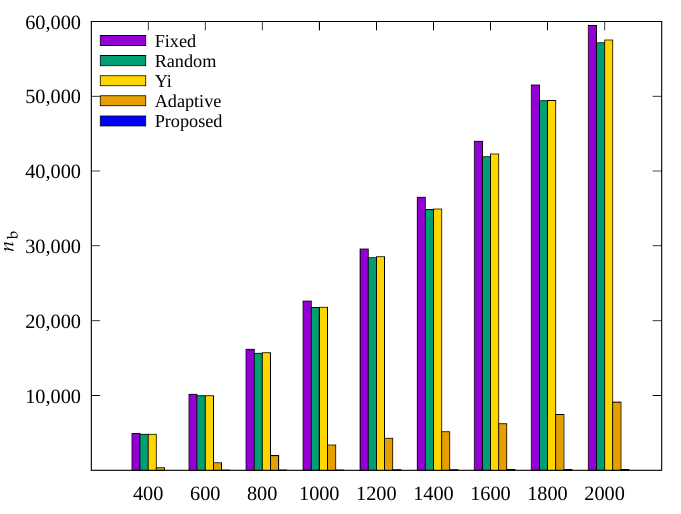
Figure 11. Change in total number of blackout nodes according to the number of